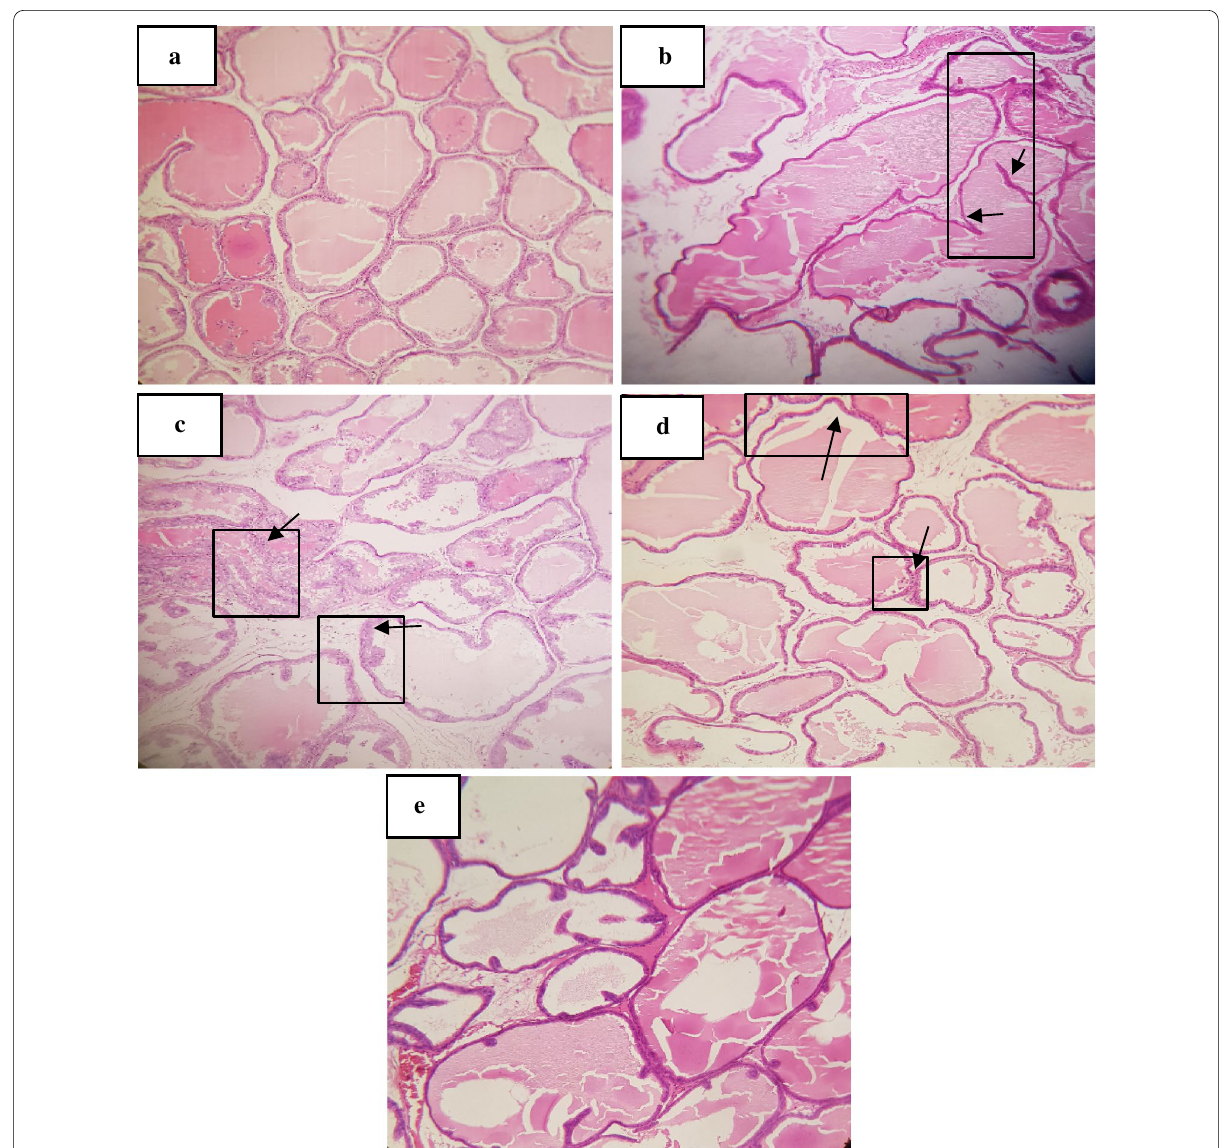
Fig. 4 Microscopic images (40 ) of the prostate tissue after staining with hematoxylin and eosin, Squares represent morphology changes like × stromal proliferation, abnormal acinar fold and hypertrophy, a Normal group, b Standard medicine group, c disease group, d group treated with 300 mg/kg JCS extract, e Group treated with 600 mg/kg JCS